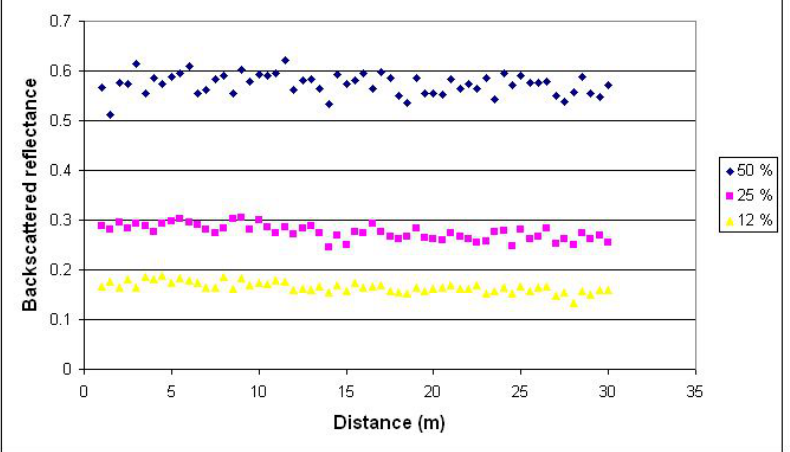
Figure 7. LEICA: 2009 distance measurement (profiler mode), calibrated with 99% Spectralon at the same distance as the